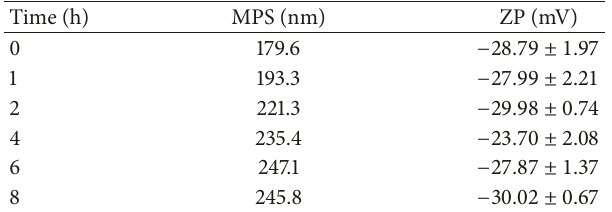
Table 9: Redispersibility of freeze-dried HCPTNPs in purified